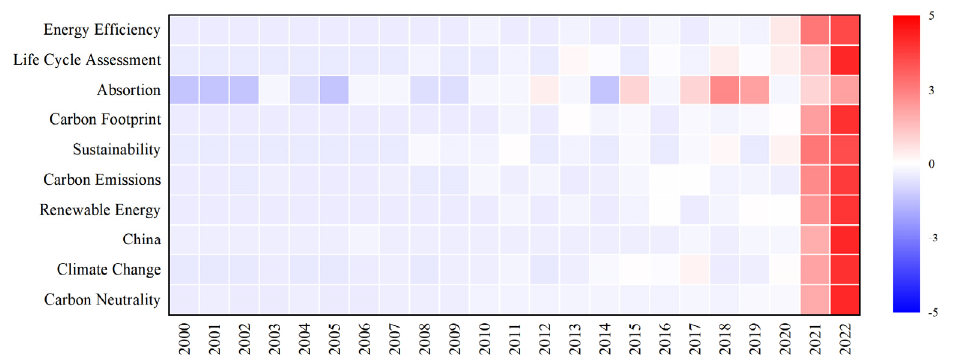
Figure 10. Heat map of keywords.